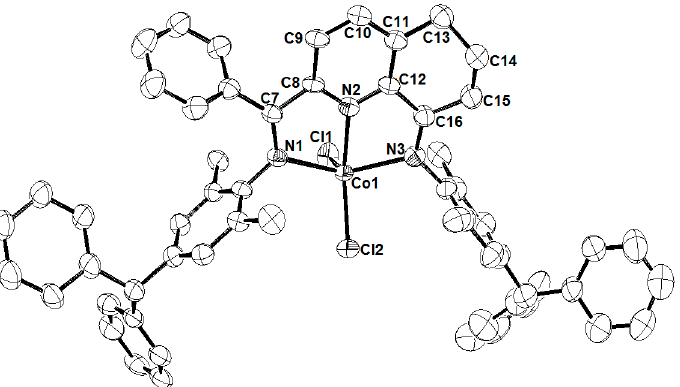
Figure 1. ORTEP representation of Co2 with the thermal ellipsoids shown at the 30% probability level. Hydrogen atoms are omitted for clarity.